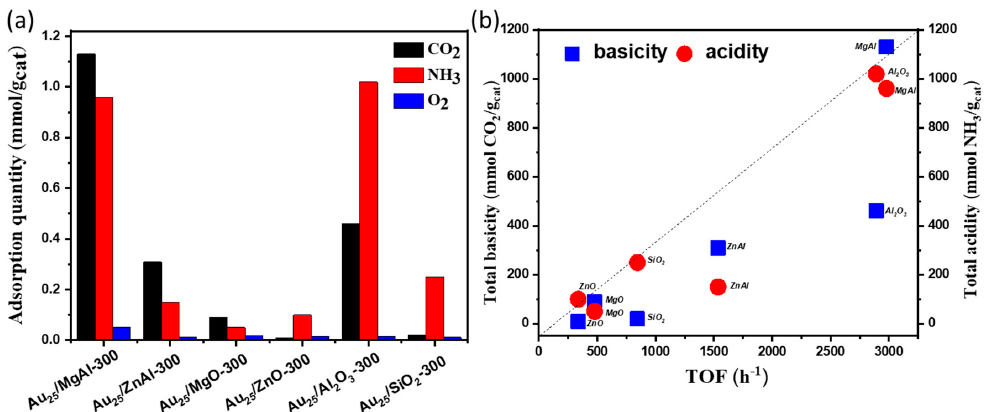
Figure 9. ( a ) the comparison of adsorption quantities of CO 2 , NH 3 and O 2 over the different supported gold catalysts by pulse adsorption tests; ( b ) the relationship between TOF values with the total basicity and acidity over different supported gold catalysts.